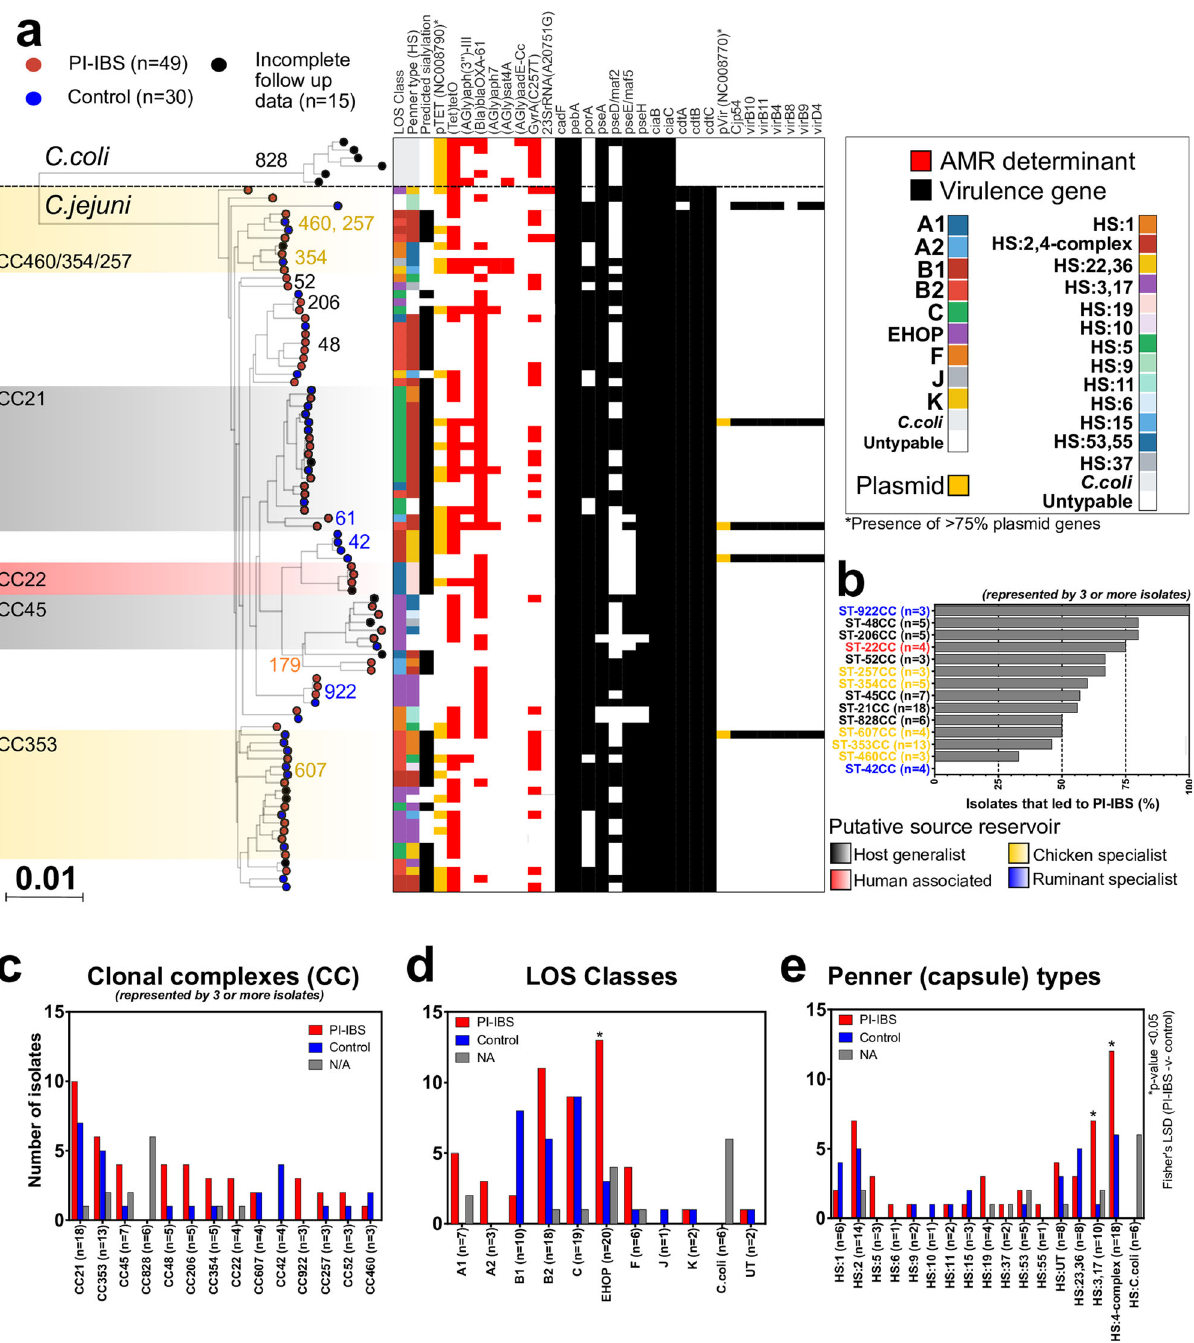
Fig. 1 Population structure of Campylobacter isolates collected in this study. a A maximum-likelihood phylogeny was constructed with IQ-TREE, using a GTR model and ultrafast bootstrapping (1000 bootstraps; version 1.6.8) 99,100 from an alignment of all isolates ( n = 94). Scale bar represents a genetic distance of 0.01. Leaves from isolates that lead to an onset of PI-IBS are colored red and those that did not (control) are blue; isolates for which follow up date was incomplete are gray. The tree is annotated with MLST, LOS, and Penner (capsule) types, presence (colored block) and absence (no block) of common Campylobacter virulence factors (VFdB), antimicrobial resistance genes (ARG-ANNOT) and the presence of two previously characterized plasmids (pTet: NC008790 and pVir: NC008770; presence indicated if 75% of more plasmid genes present). Interactive visualization is available on Microreact 101 : https://microreact.org/project/CampyIBS. b Ratio of how many isolates from each MLST clonal complexes (CC) lead to the onset of PI-IBS. Only CCs represented by three or more isolates are shown. Frequency of c clonal complexes, d LOS classes and e Penner types identi fi ed. p -value < 0.05 indicated with (*); Fisher ’ s LSD test. Raw data for ( b – e ) available in Supplementary Data